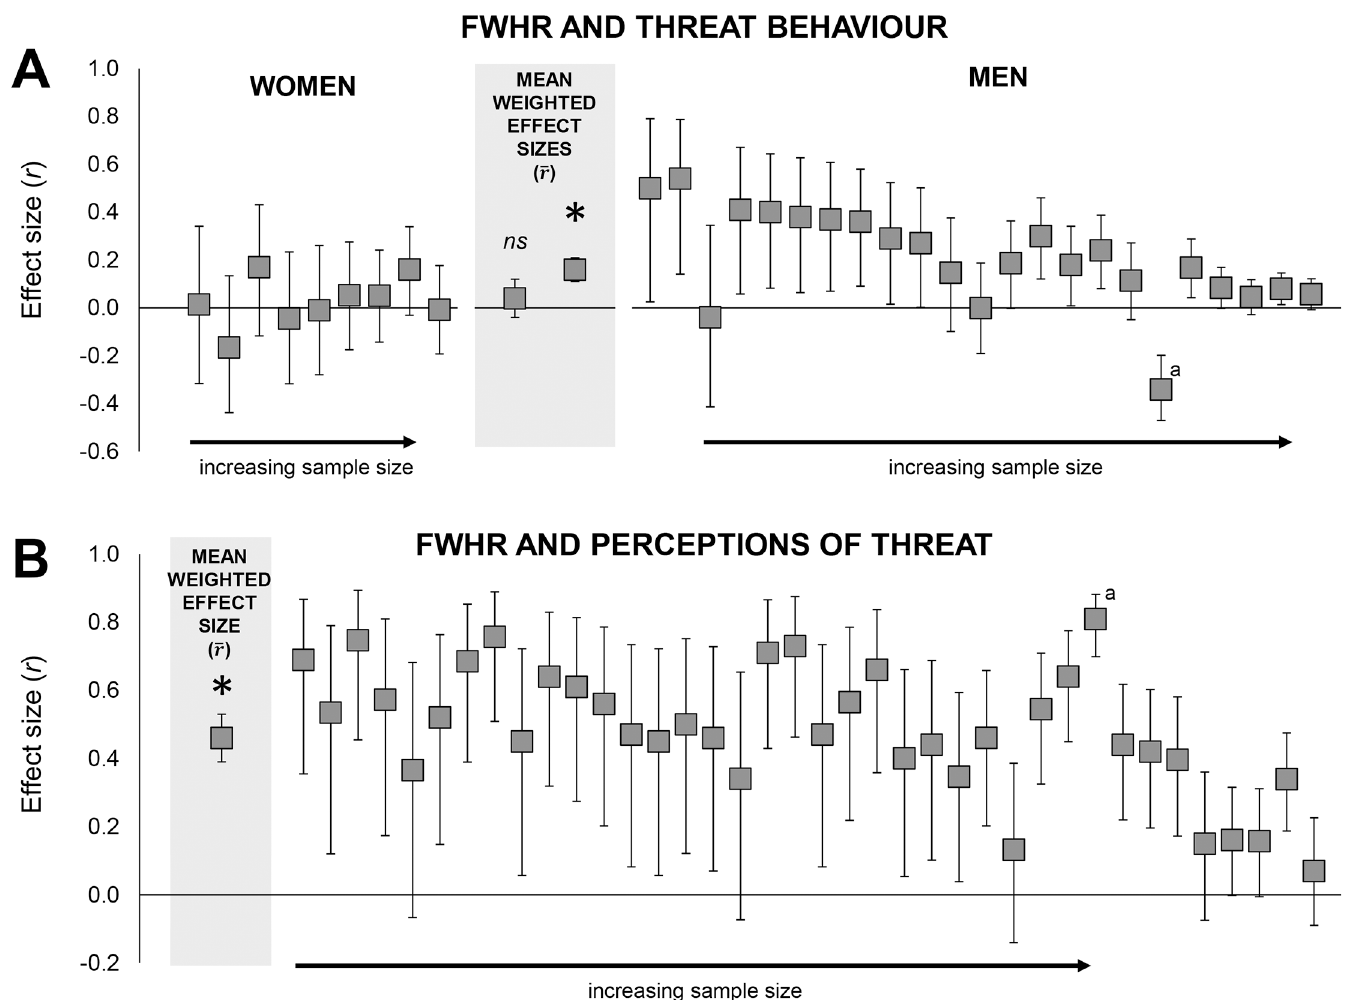
Fig 2. Effect sizes ( r s) included in the meta-analysis on the relationships between the FWHR and threat behaviour (Panel A) and between the FWHR and perceptions of threat (Panel B). The mean weighted effect sizes ( r s ) are highlighted in grey, with men and women separated for Panel A and combined for Panel B. * p < .0001. a effect size was removed from the fi nal